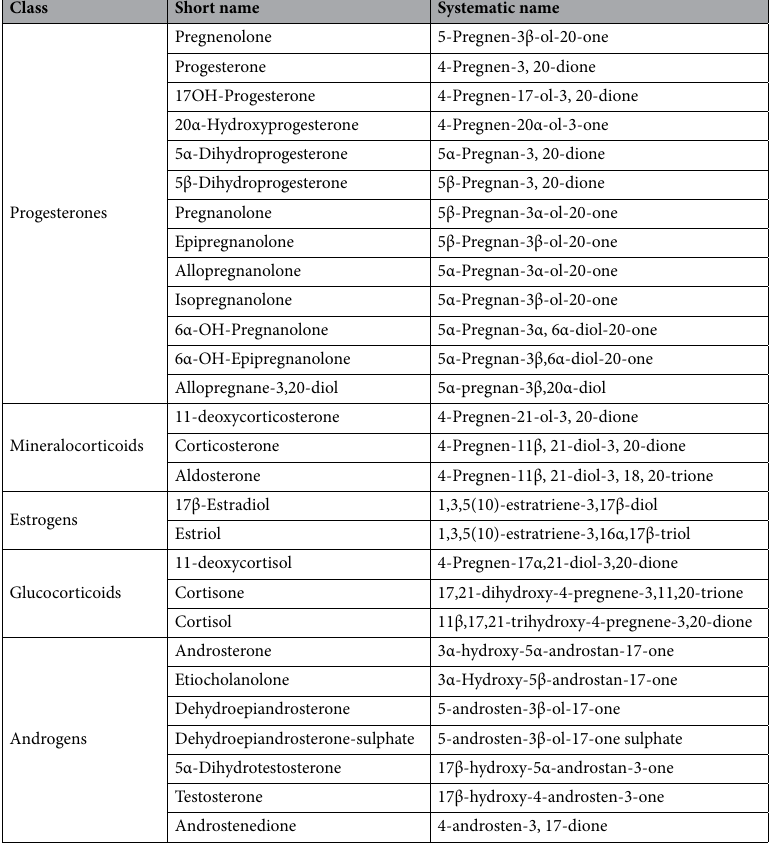
For LC–MS analysis, a Vanquish UHPLC (equipped with an ACQUITY UPLC HSS T3 Column, 100 Å,